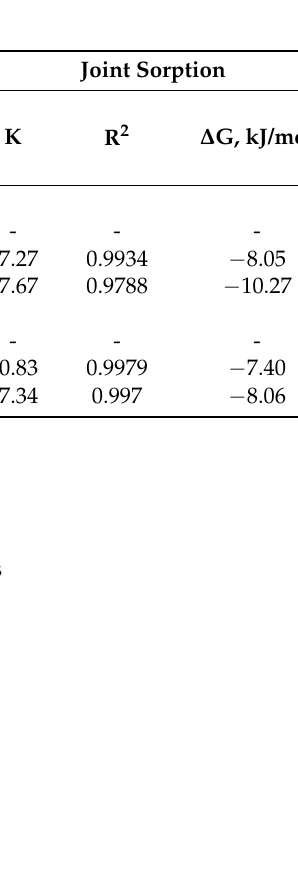
Table 3. Apparent constants of sorption equilibria, regression coefficients and standard Gibbs energy values of ion exchange of platinum and iridium sorption from individual and combined sulfate-chloride solutions.